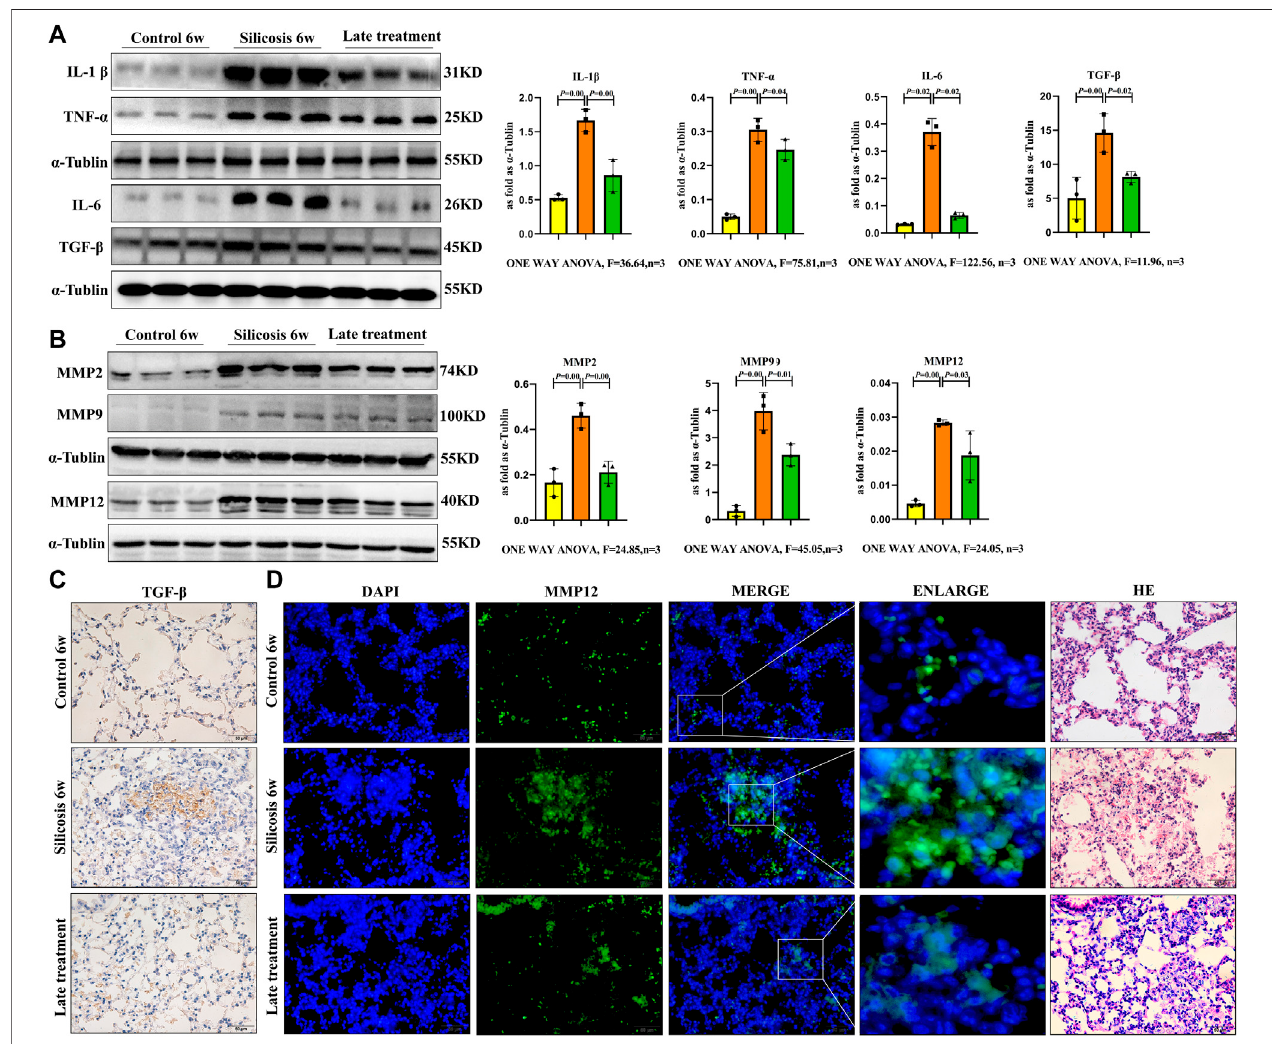
FIGURE8| SiO 2 signi fi cantlyelevated fi broticandSASPproteinexpressionlevelsinthelungtissueofsilicosismodel. (A) IL-1 β ,IL-6,TNF- α andTGF- β 1expression levelsweredetected bywesternblot. (B) MMP2, MMP9and MMP12expression levelsweredetected bywesternblot. (C) ImmunohistochemistrystainingforTGF- β 1in the lung. (D) Immuno fl uorescence staining for MMP12 in the lung. Data are presented as the mean ± SD. n = 3 per group.